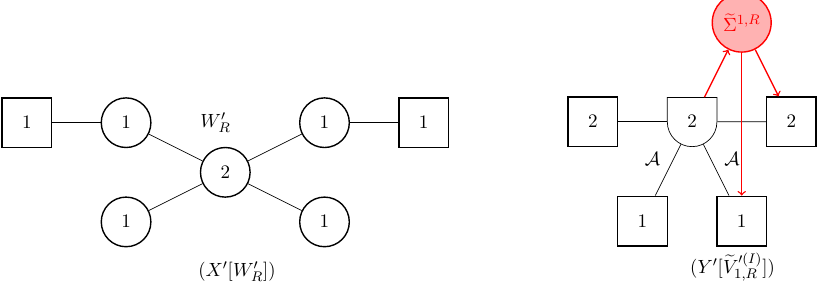
Figure 50 . Wilson defect in a flavored b D 4 quiver, and its dual vortex defect in a U(2) gauge theory.